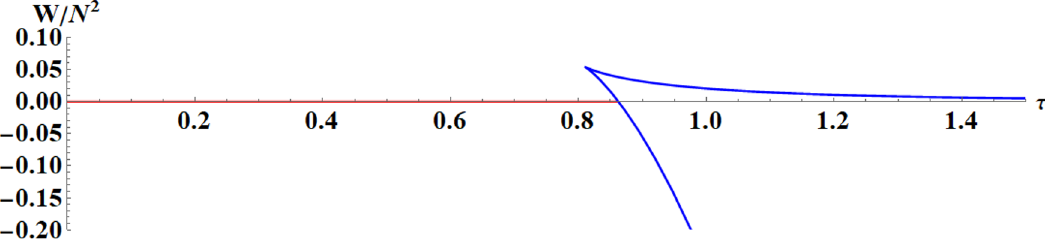
Figure 9 . BPS free energy W/N 2 vs. BPS temperature τ . This phase diagram displays an upper (small black hole) branch and a lower (large black hole) branch. The two branches coincide at the cusp ( τ 2 ) ≈ (0 . 809 , 0 . 055) . The large black hole branch dominates over the BPS gas cusp , W cusp /N with W = 0 (red line) for τ > τ 0 . 863 HP ≈